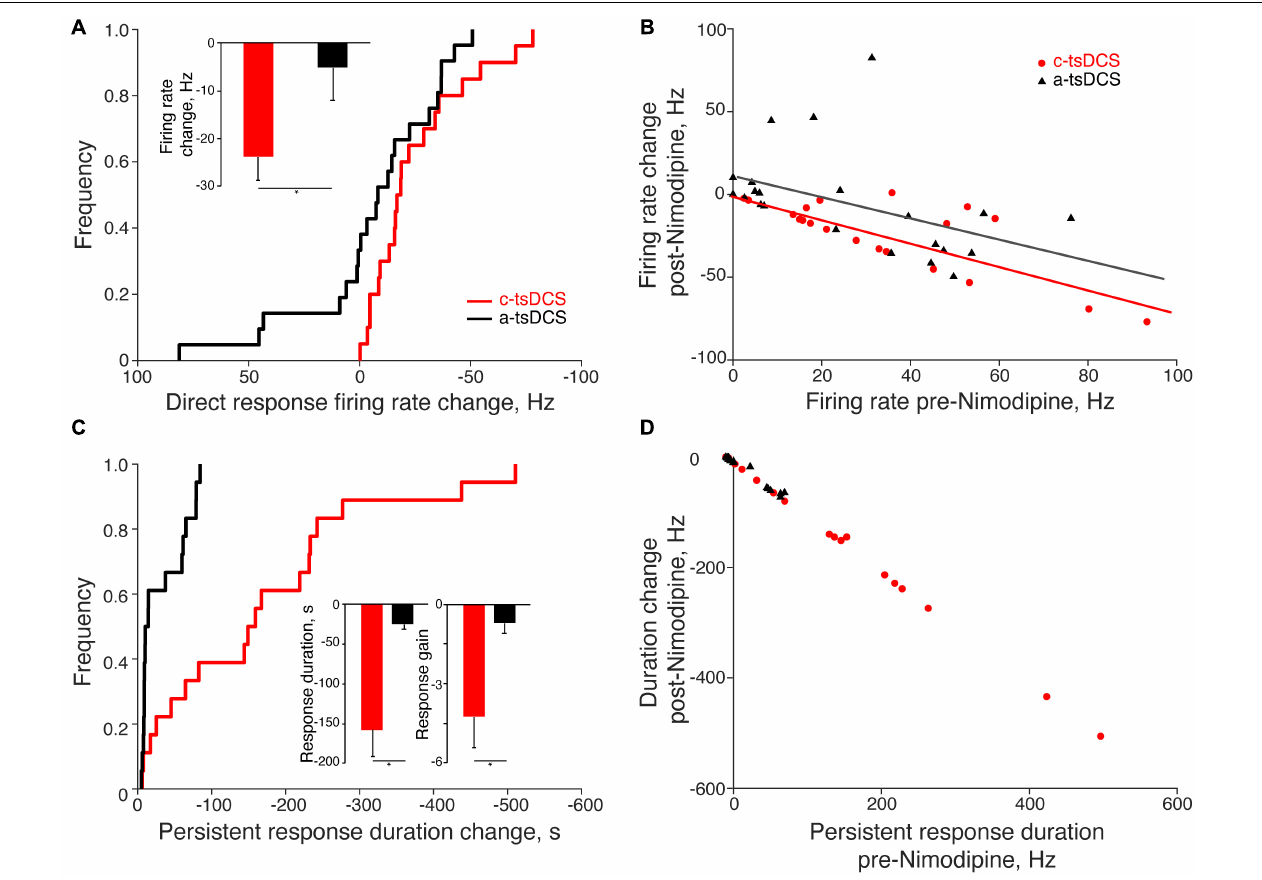
FIGURE 5 | Quantification of the effects of Nimodipine on the direct and persistent responses of single motor units. (A) The change of the direct response firing rate (post-Nimodipine response minus pre-Nimodipine response) was significantly larger for cathodal-tsDCS (c-tsDCS) than for anodal-tsDCS (a-tsDCS) (K-S test, * p = 0.046) as shown in the cumulative distribution histogram. The inset plots the reduction in the firing rate during the direct response; the reduction was significantly greater for c-tsDCS than for a-tsDCS ( t -test, * p = 0.03). (B) The blockade effect of nimodipine was correlated with the direct response amplitude; each data point represents a single motor unit (c-tsDCS regression line: slope: − 0.70, R-sq: 0.59, p = 0.0001; a-tsDCS regression line: slope − 0.62, R-sq:0.20, p = 0.04). (C) The change in duration of the persistent response (post-Nimodipine response minus pre-Nimodipine response) was significantly greater for c-tsDCS than for a-tsDCS (K-S test, * p = 0.0005). The insets plot the reduction in the duration (left), and gain (right) of the persistent response for both c- and a-tsDCS; the blockade effect of Nimodipine was significantly stronger for c-tsDCS than for a-tsDCS ( t -test, duration * p = 0.0002; gain * p = 0.04). (D) The effect of blockade was correlated with the persistent response strength; each data point represents a single motor unit (c-tsDCS regression line: slope: − 1.00, R-sq: 1.00, p = 1e-28; a-tsDCS regression line: slope − 0.92, R-sq:0.98, p =